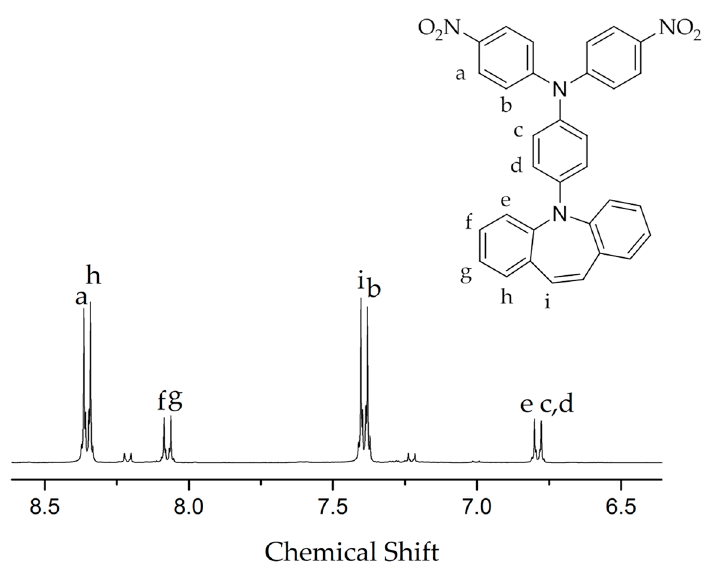
Figure A2. 1 H NMR spectrum of M2 in DMSO- d 6 .